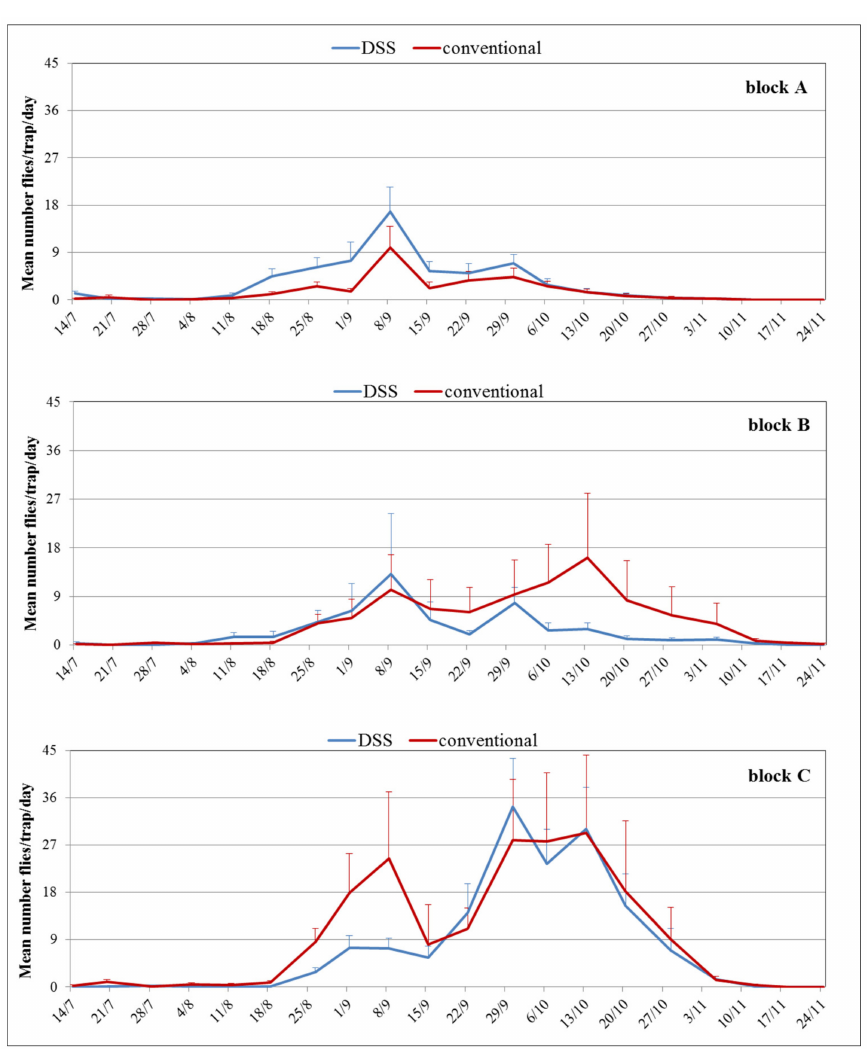
Figure 4. Mean medfly trapping levels calculated during the 2015 growing season from six e-traps for DSS-assisted plots and from six Jackson traps for conventional plots in blocks A, B, and C.